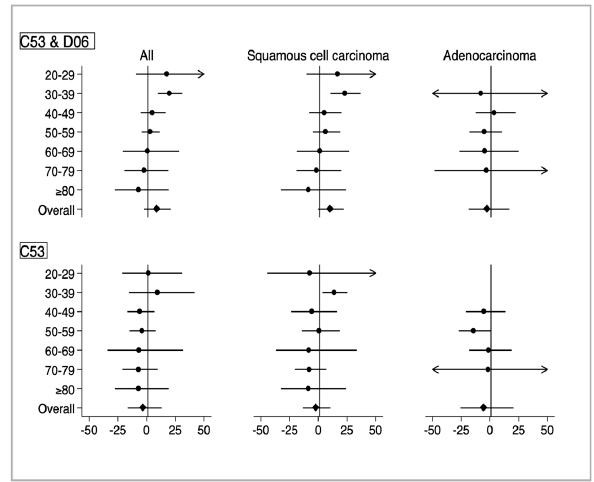
Figure 2. Age-specific average annual percent change for cervical cancer stratified by histological subtype. The average annual percent change (dot) and 95% confidence intervals (line) were estimated using joinpoint regression analyses. Upper panels indicate data of overall cervical cancer patients, including those with carcinoma in situ (ICD-10, D06) and invasive cancer (C53). Lower panels indicate data of those with only invasive cervical cancer (C53). Table 2. Age-specific average annual percent change estimated with joinpoint regression stratified by histological subtype for